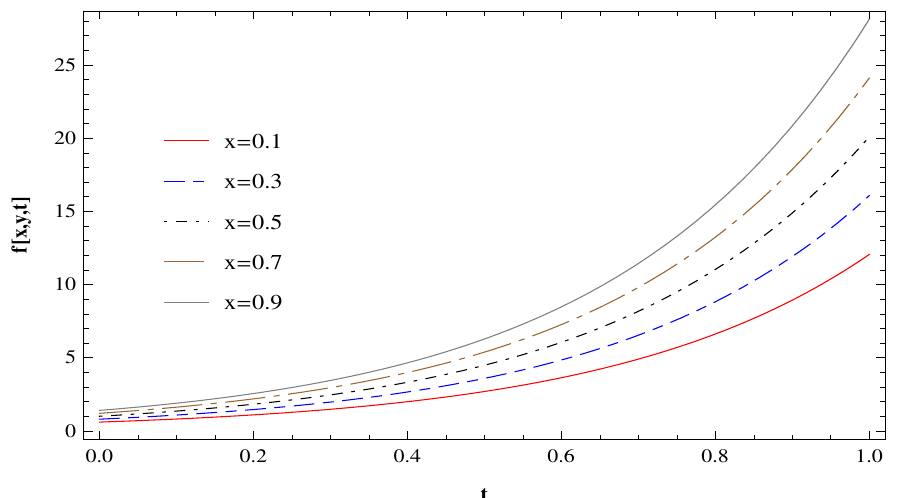
Figure 8. The FRDTM solutions f ( x , y , t ) for different values of x ; β = 1; t ∈ [ 0,1 ] , and y =